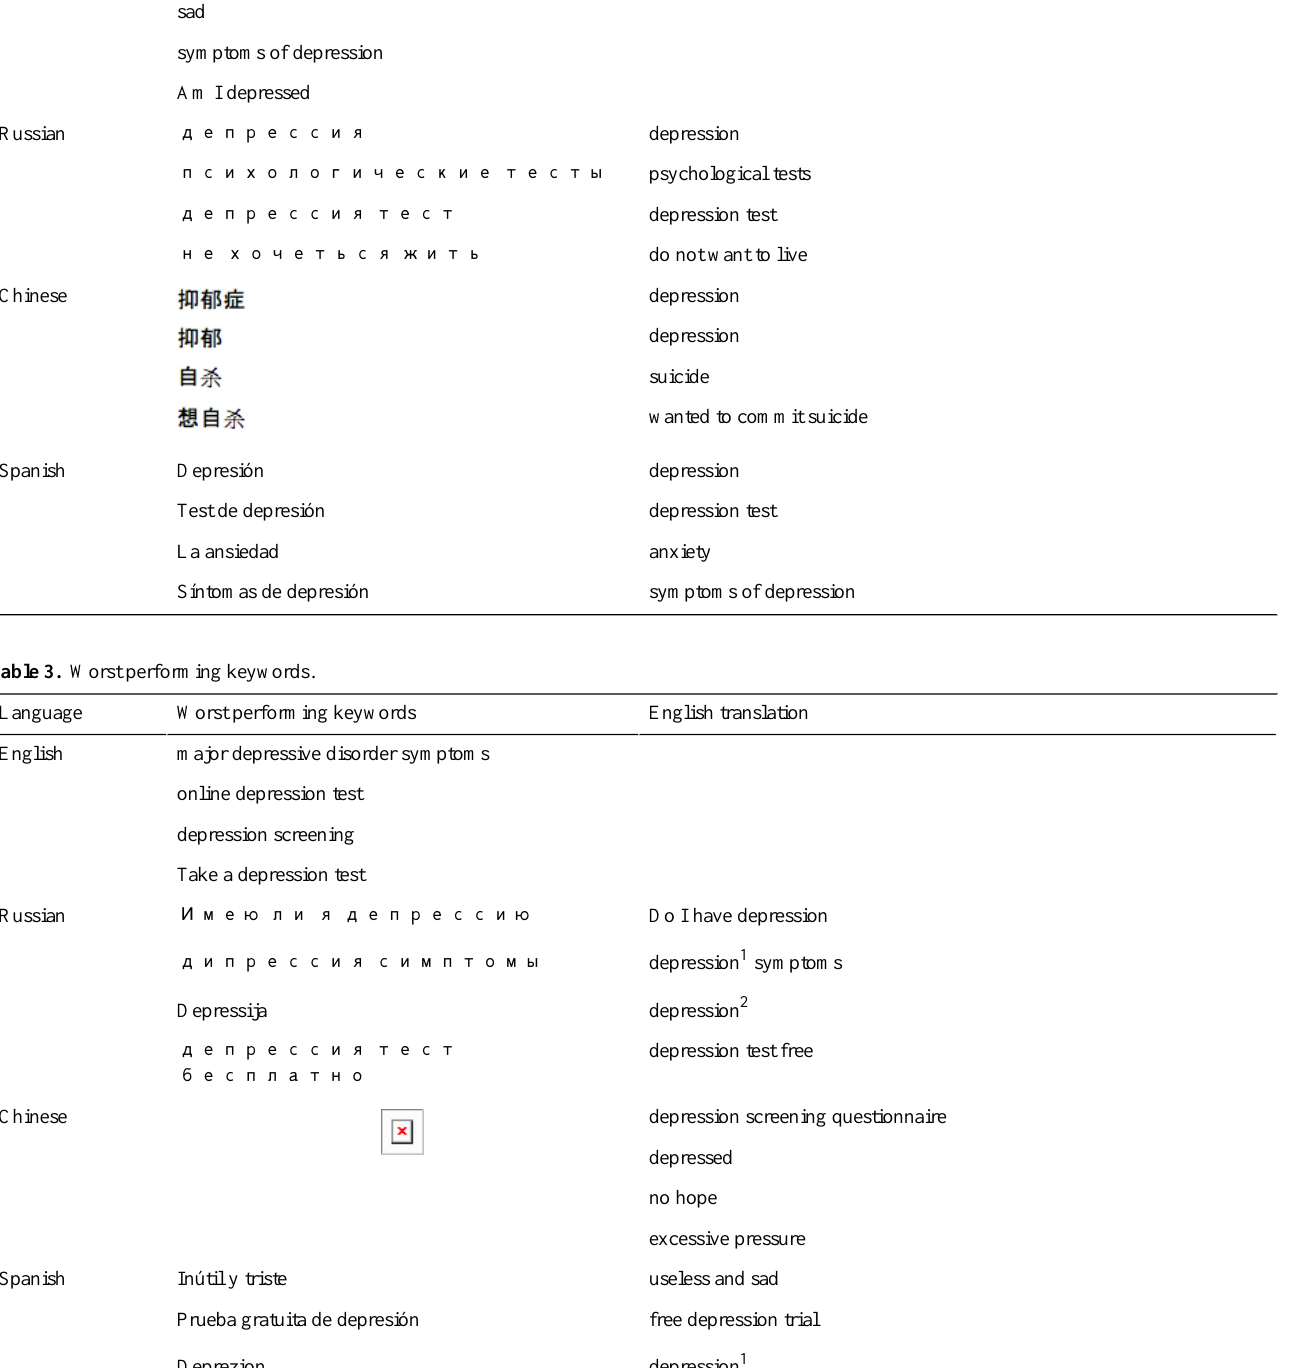
English translationBest performing keywordsLanguage